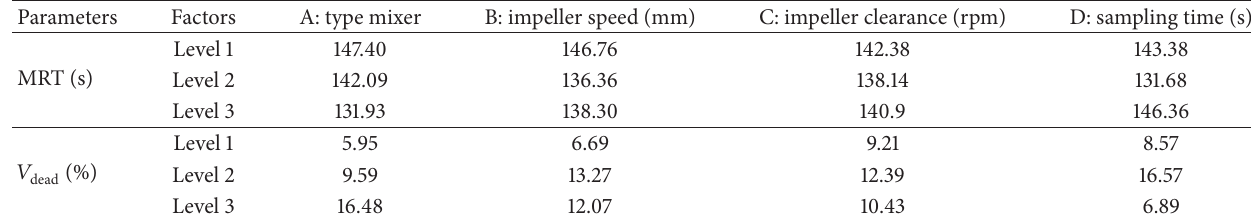
Table 4: The means of each level for four factors.